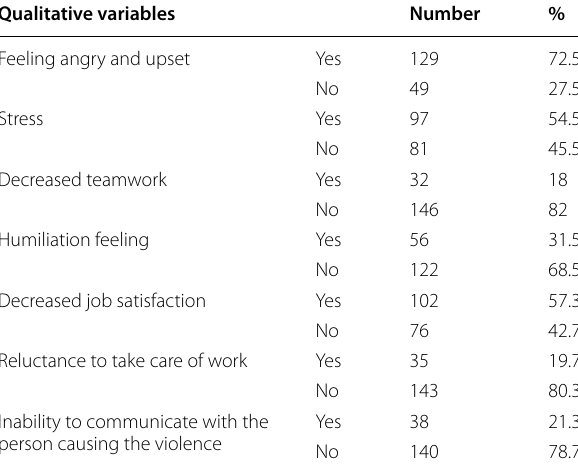
Table 4 Frequency distribution of the impact of violence on